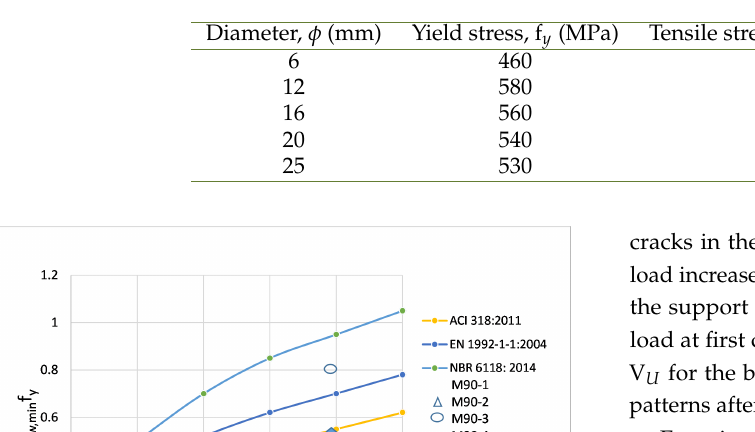
Table 4. Properties of reinforcing steel